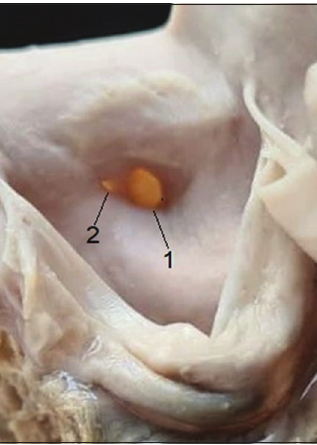
FIGURE 5. Third coronary artery (TCA) orifice at the 10 o’clock position (1. right coronary artery and 2.